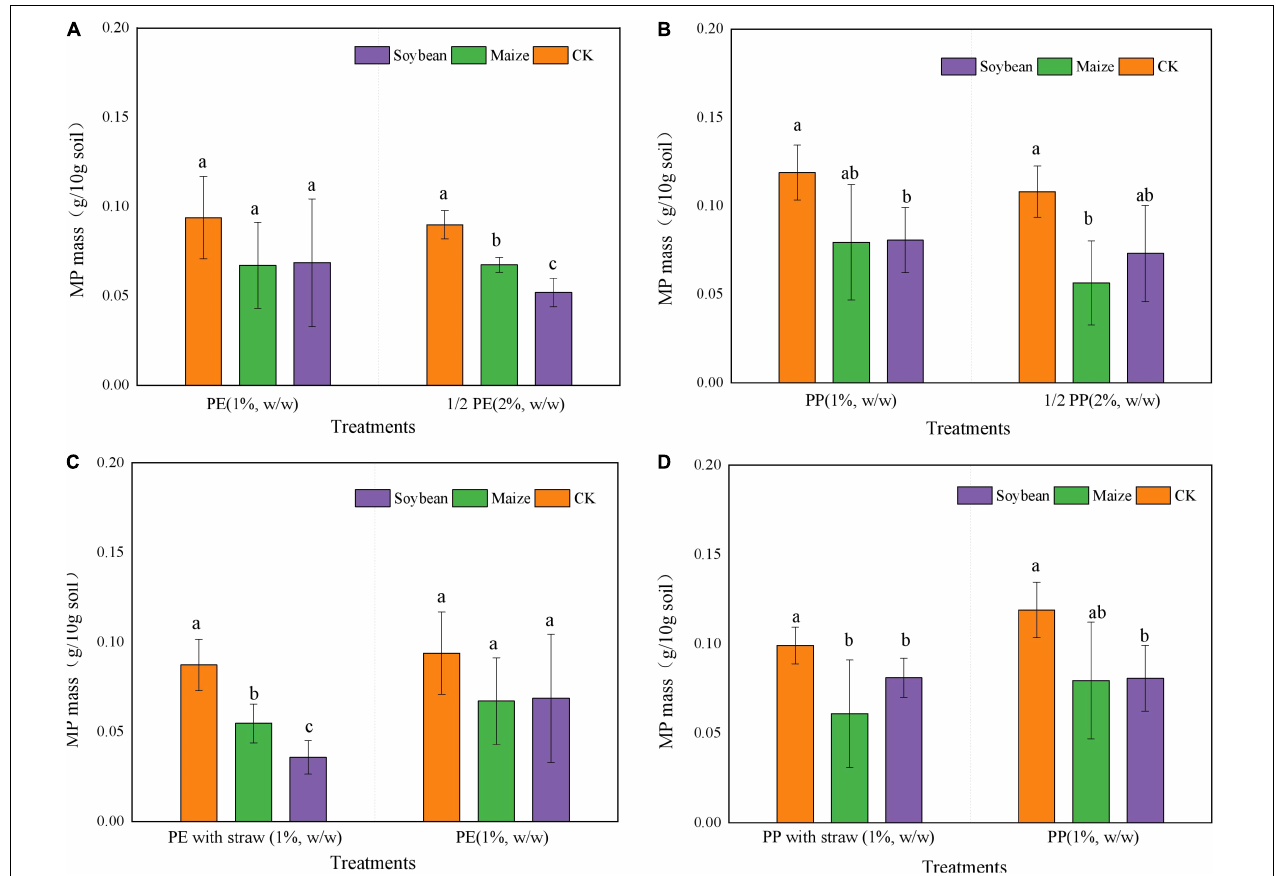
FIGURE 5 | Mass content (g 10 g - 1 soil) of low-density polyethylene (LDPE) and low-density polypropylene (LDPP) differed in the treatments of crop growth (soybean and maize, with and within straw addition). (A–D) LDPE-MP, LDPP-MP, LDPE-MP (with straw), and LDPP-MP (with straw). CK was the control treatment without crop growth. Columns followed by the same letter were not significantly different based on a least significant difference (LSD) multiple range test ( p <